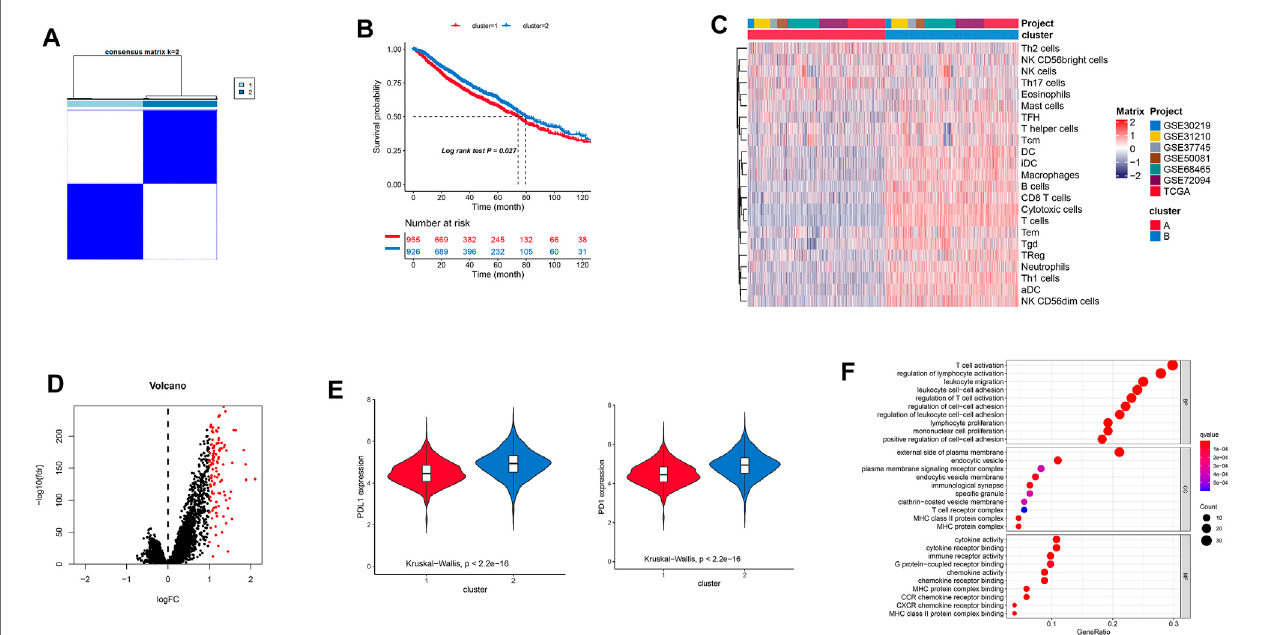
FIGURE 1 | (A) Consensus clustering-based identi fi cation of two clusters ( n = 1,881). Sample consensus is displayed by heatmaps shown in white (consensus value = 0) for samples that never aggregated jointly and blue color (consensus value = 1) for samples that always aggregated jointly. (B) Survival analysis ofpatients with twoclusters. (C) Landscapeimmune cellin fi ltration intwoclusters. (D) Differentialgeneexpressions areimagedbyavolcanoplot. (E) DifferentexpressionsofPD-1/PD- L1 in the two clusters. (F) GO analysis showing differential gene